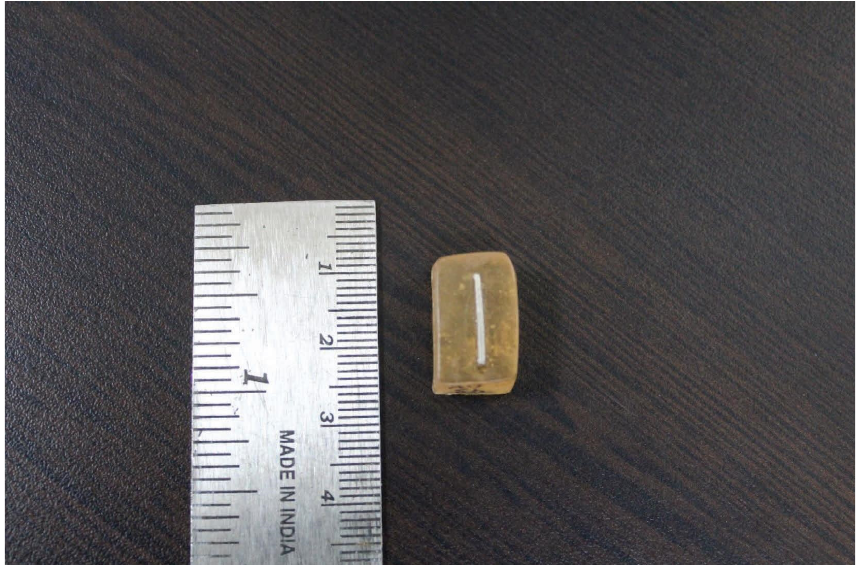
Figure 2: Samples embedded in polymethyl methacrylate